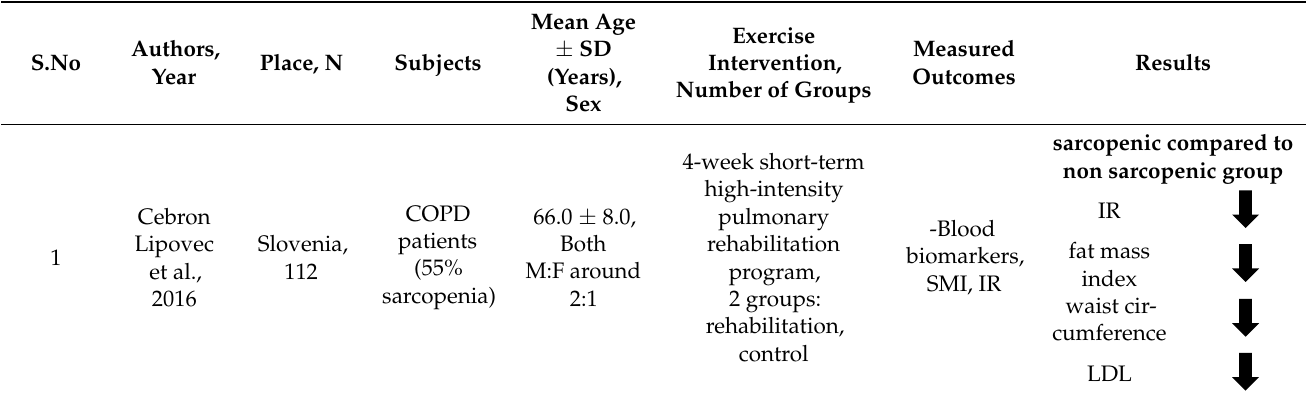
Table 5. Effect of exercise on subjects with sarcopenia and lung disease. Table 1. Effect of exercise on subjects with cancer and baseline measurement of sarcopenia.